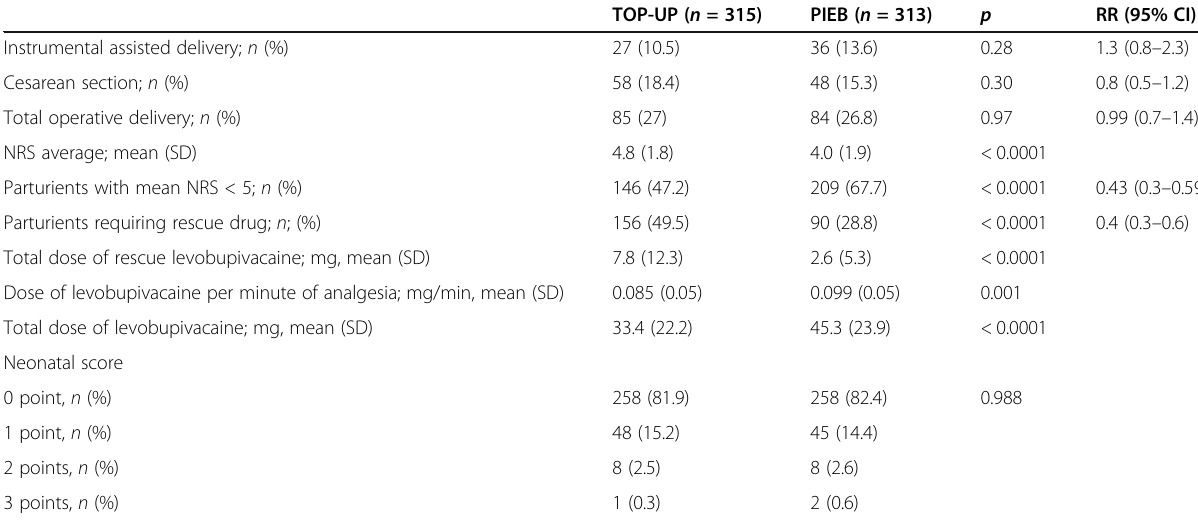
Table 2 Primary and secondary